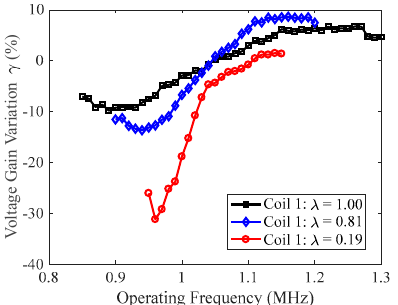
Figure 14. MO. ( a ) Photograph, ( b ) positions.